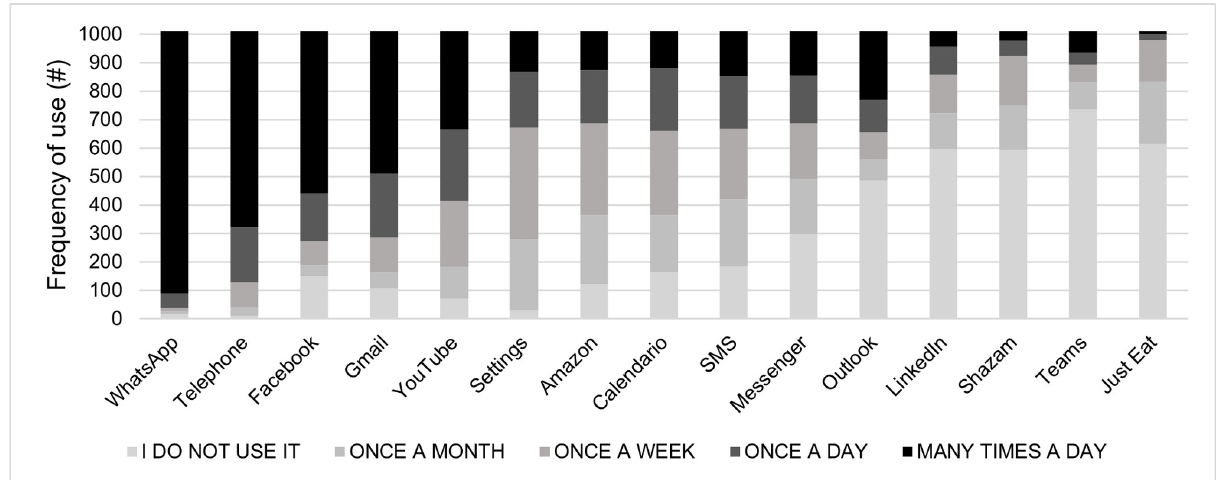
Fig 1. Apps usage habits (N = 1009). Results have been displayed according to the frequency of use (descending order).